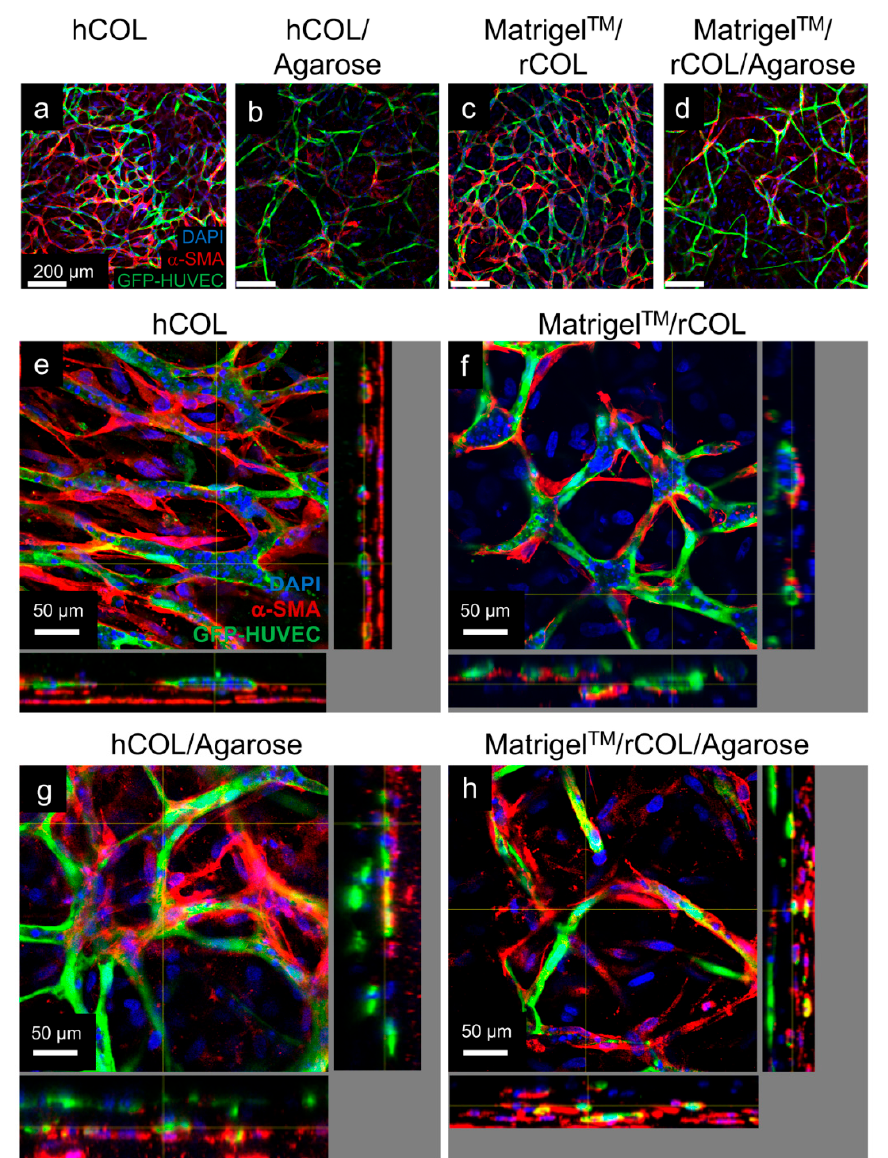
Figure 5. Confocal images of GFP-HUVECs co-cultured with hASCs and stained for α -SMA. Constructs containing hCOL ( a , e ), hCOL / Agarose ( b , g ), Matrigel TM / rCOL ( c , f ), and Matrigel TM / rCOL / Agarose ( d , h ) were analyzed after 14 days of cultivation. ( a – d ) Confocal images displaying an overview in a low magnification. ( e – h ) Virtual stacks of high magnification images with respective orthogonal views. α -SMA positive cells wrap around GFP-HUVEC cords under all conditions. Scale bar: ( a – d ): 200 µ m, ( e – h ): 50 µ m.